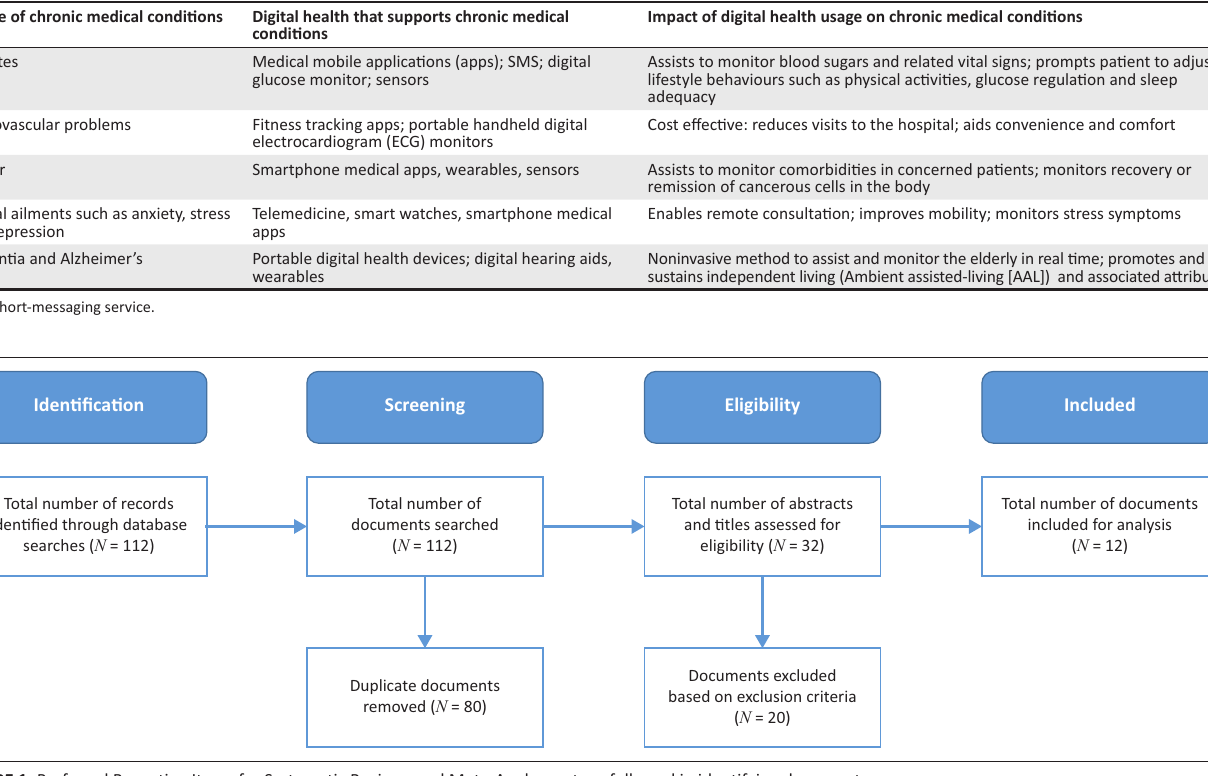
FIGURE 1: Preferred Reporting Items for Systematic Reviews and Meta-Analyses steps followed in identifying documents.